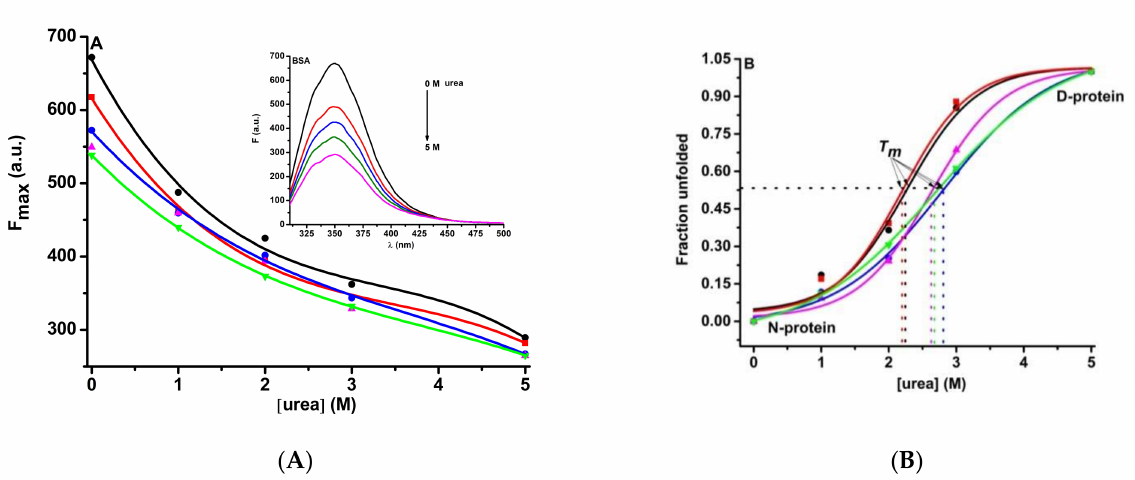
Figure 8. ( A ) BSA (3 µ M) denaturation by urea in the presence of the ferrihydrite nanoparticles (3 µ M). ( B ) Unfolding curves corresponding to: BSA ( • ), BSA-S1 ( • ), BSA-S2 ( (cid:4) ), BSA-S3 ( (cid:78) ), and BSA-S4 ( (cid:72) ) samples.